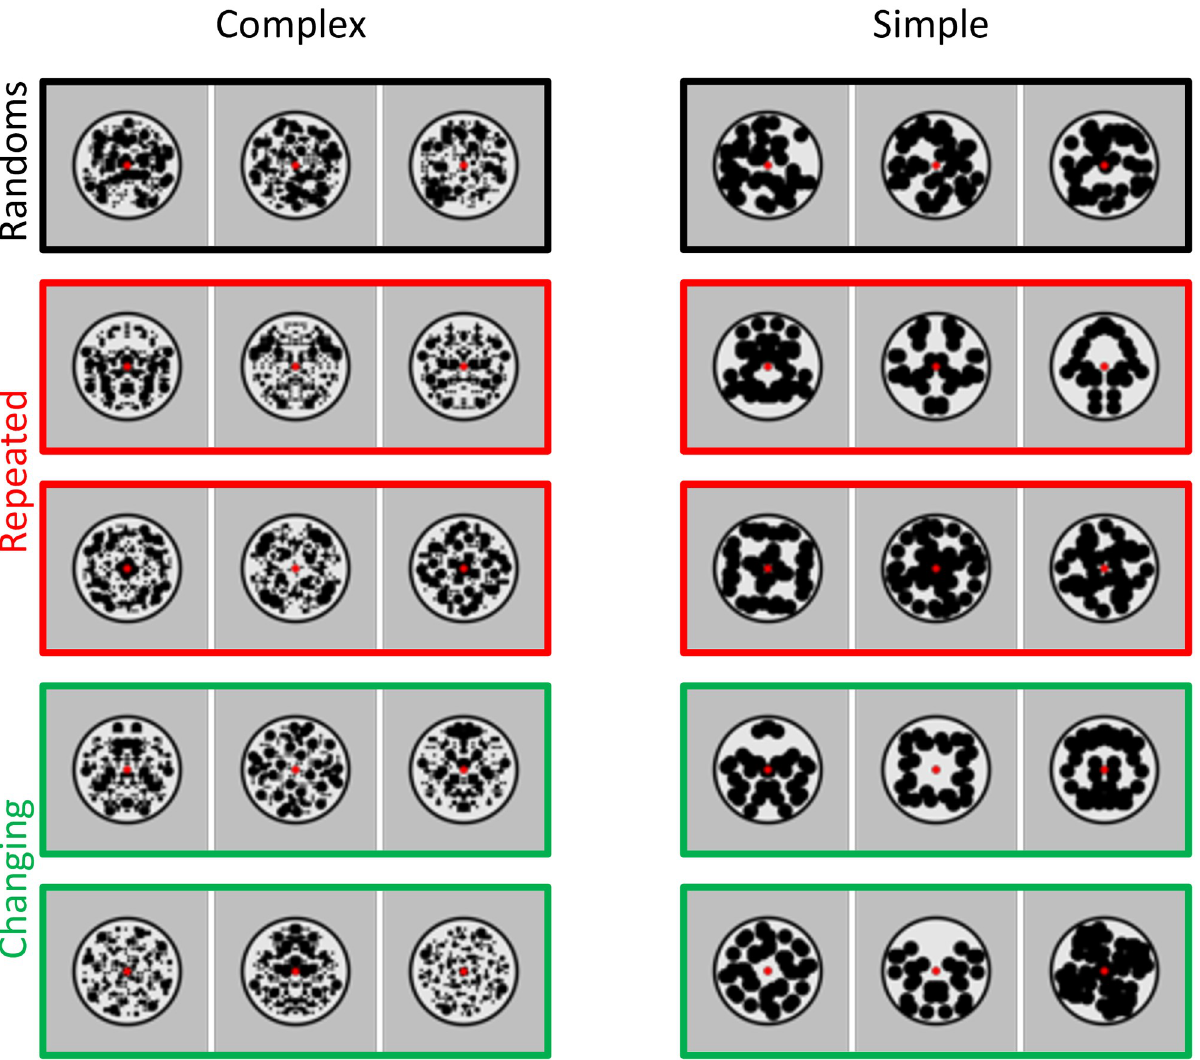
Fig 12. Experiment 5 stimuli. 24 participants were presented with complex patterns (left column) and another 24 were presented with simple patterns (right